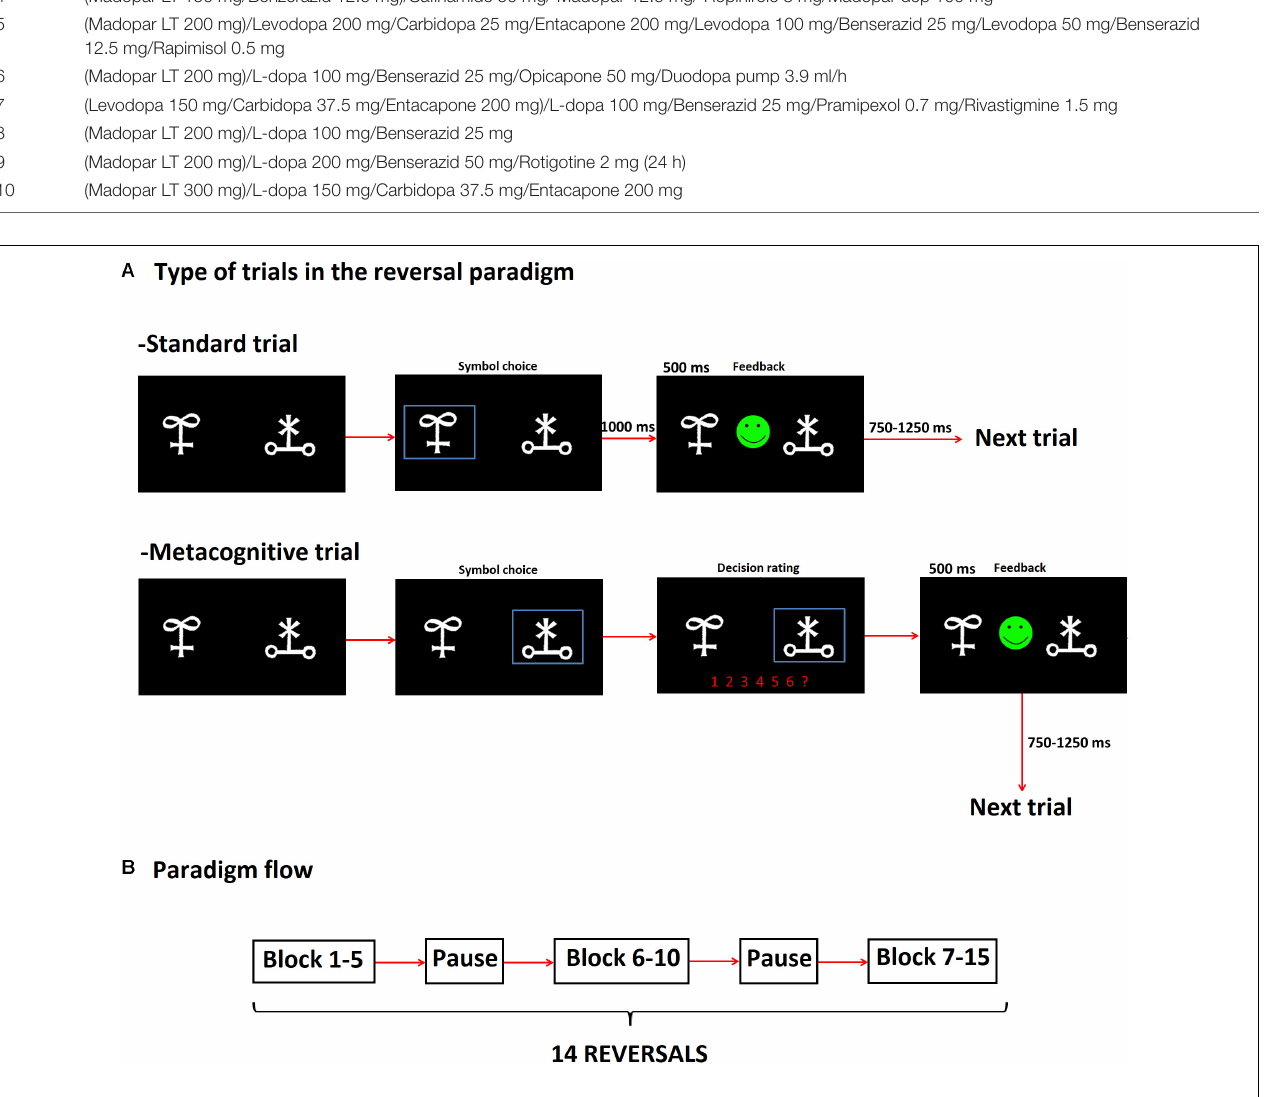
FIGURE 1 | Scheme of the reversal learning (RL) task that incorporated metacognitive assessment. (A) The RL task included trials with and without metacognitive assessment, which we termed as Metacognitive and Standard trials, respectively. The order of presentation of such trials was random, (B) Paradigm blocks: each subject completed 15 blocks (divided in three sections), after block 5 and 10 there was a pause. The three blocks comprised 14 reversals in total. The criterion to reach reversal was as follows: a subject needed to complete 10 consecutive right trials. After such criterion was fulfilled, there was a 25% chance for reversal to occur in the next five trials as long as the subject kept on performing consecutive right trials. If subjects chose the wrong symbol before reaching the specified number of consecutive right trials, they had to begin